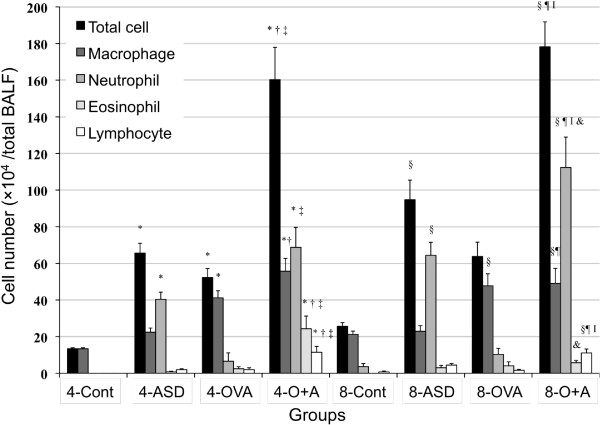
Cellular profile in bronchoalveolar lavage fluid (BALF). All values expressed as mean ± SE. *p < 0.001 vs 4-Control, †p < 0.01 vs 4-Control, ‡p < 0.05 vs 4-Control, §p < 0.001 vs 4-ASD, ¶p < 0.001 vs 4-OVA, Ip < 0.001 vs 8-Control,**p < 0.01 vs 8- Control, ††p < 0.001 vs 8- ASD, ‡‡p < 0.01 vs 8-ASD, §§p < 0.05 vs 8-ASD, ¶¶p < 0.001 vs 8-OVA, IIp < 0.001 vs 4-O+A, †††p < 0.01 vs. 4-O+A, &p < 0.05 vs 4-O+A.